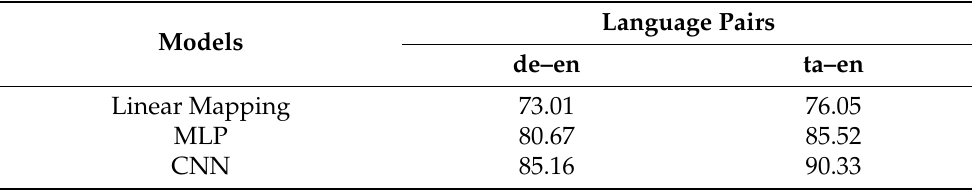
Table 10. Accuracy of German–English and Tamil–English BDI system as reported in